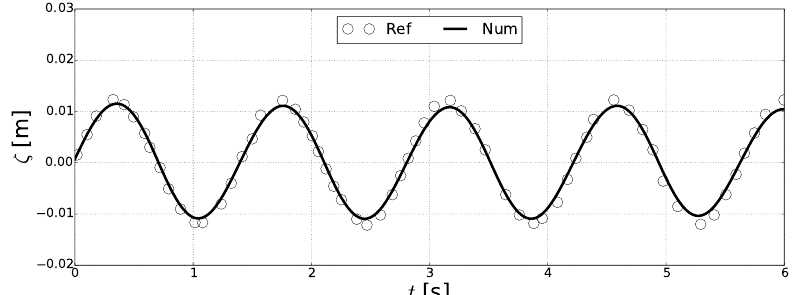
Figure 18. Numerical solution for the heave motion over time with regular waves. The numerical reference solution was taken from [54].